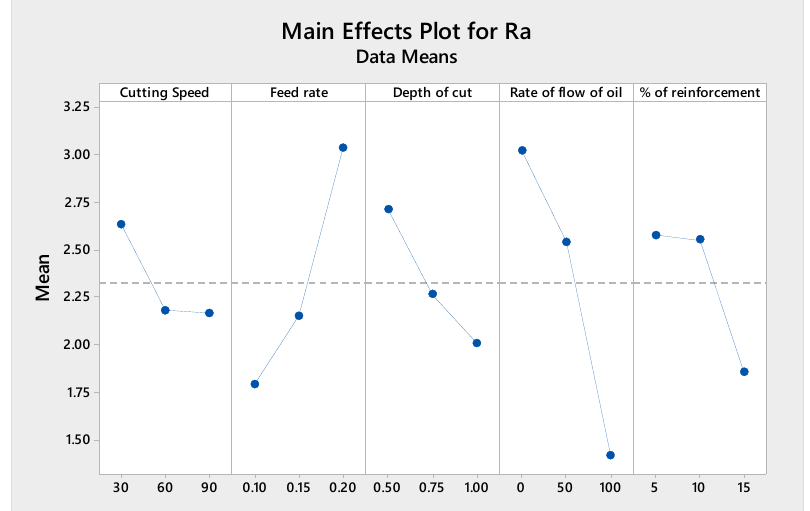
Figure 4. Mean effects plot for surface roughness.